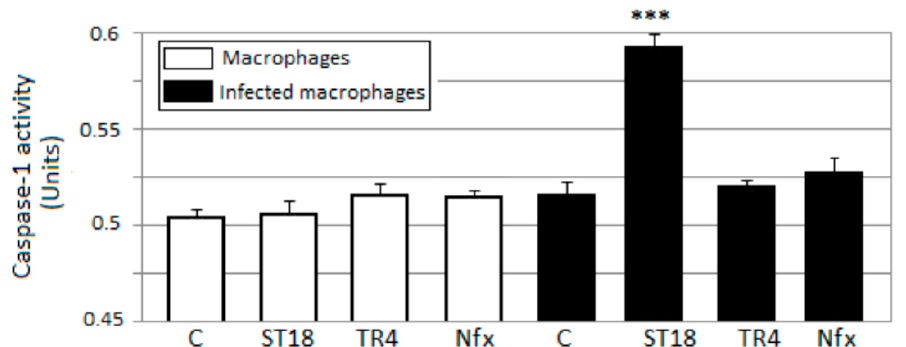
Figure 7. Caspase-1 activity. Levels of active caspase-1 in U937 macrophages infected with T. cruzi epimastigotes after 48 h of treatment with 50 µM ST18, TR4 and Nifurtimox (Nfx). C = untreated control. Bars indicate the means ± SEs from four independent experiments. *** p < 0.05 vs. control.